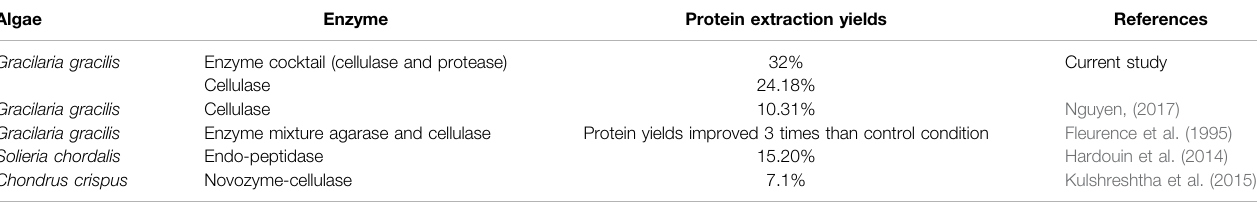
TABLE 3 | Comparison the release of protein from different enzymes and red algae. Algae Enzyme Protein extraction